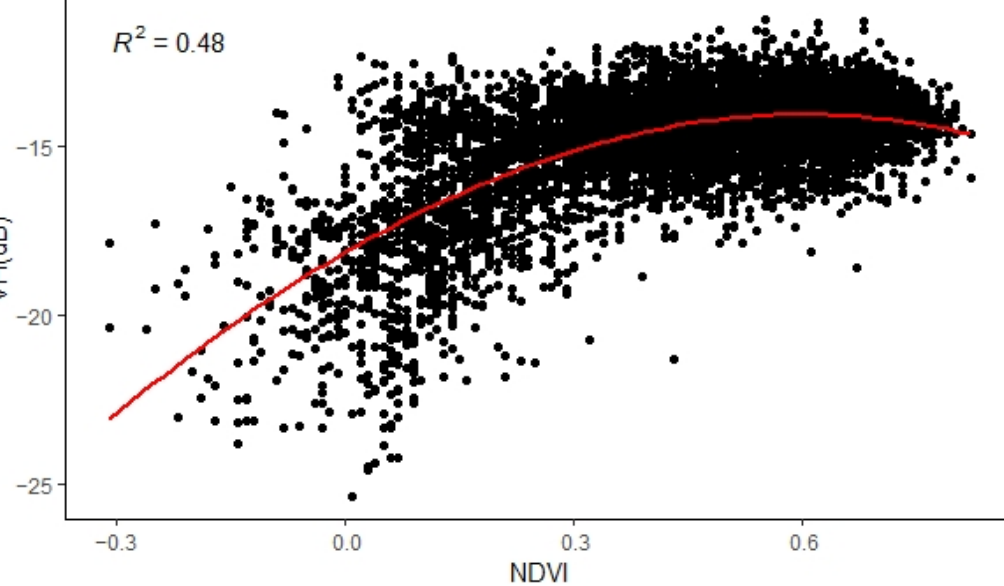
Figure 5. The correlation between NDVI and VH backscatter from multiple-incidence angles using the polynomial regression model.